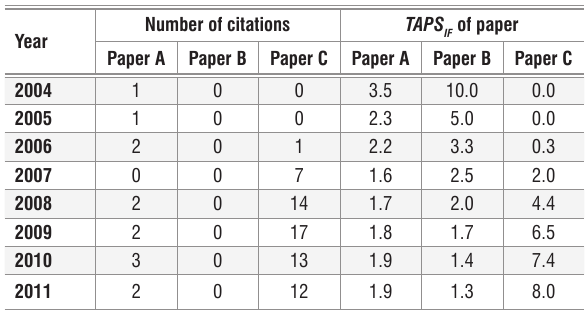
An illustrative example showing the computation of the temporally averaged paper-specific impact factor ( TAPS three hypothetical